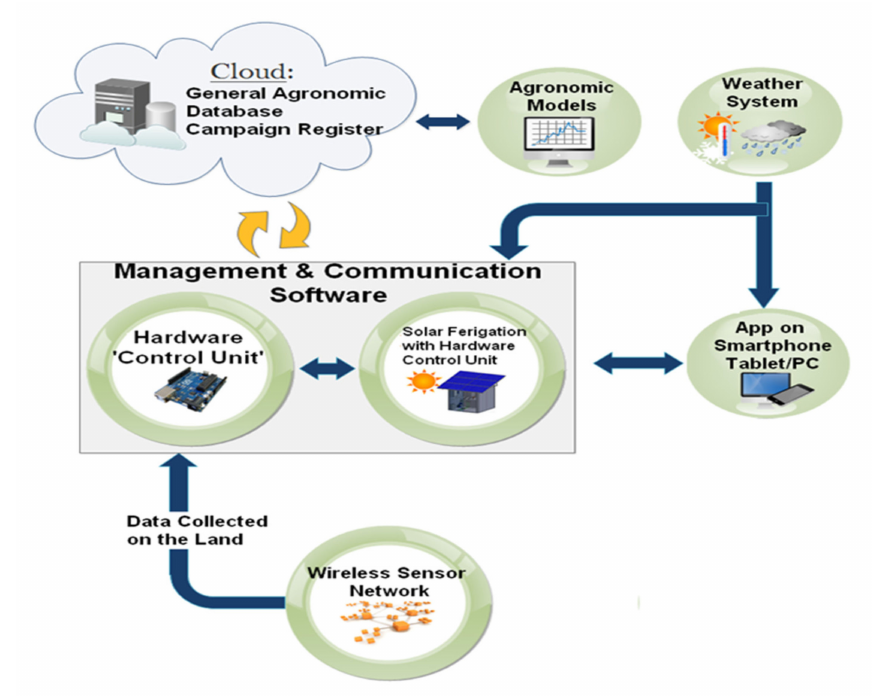
Figure 7. Functional scheme of developed fertigation system with the di ff erent hardware and software sections and related data-flow between them; the collected data on the land are processed by the control unit and then shared with the remote general agronomic database in order to be combined with the agronomic and sustainability models as well as weather conditions or